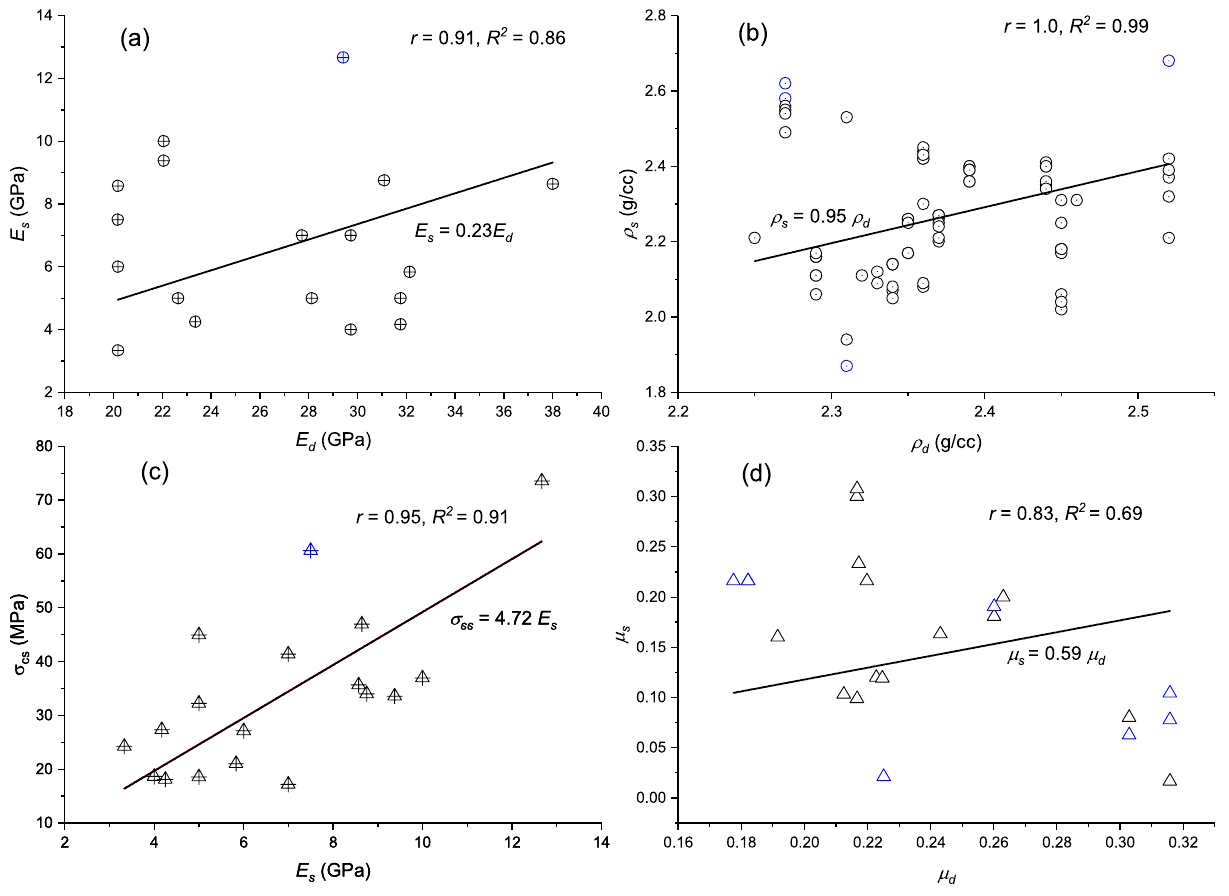
Figure 8. Regression model for static and dynamic properties such as ( a ) modulus of elasticity, ( b ) density, ( c ) UCS and modulus of elasticity, and ( d ) Poisson’s